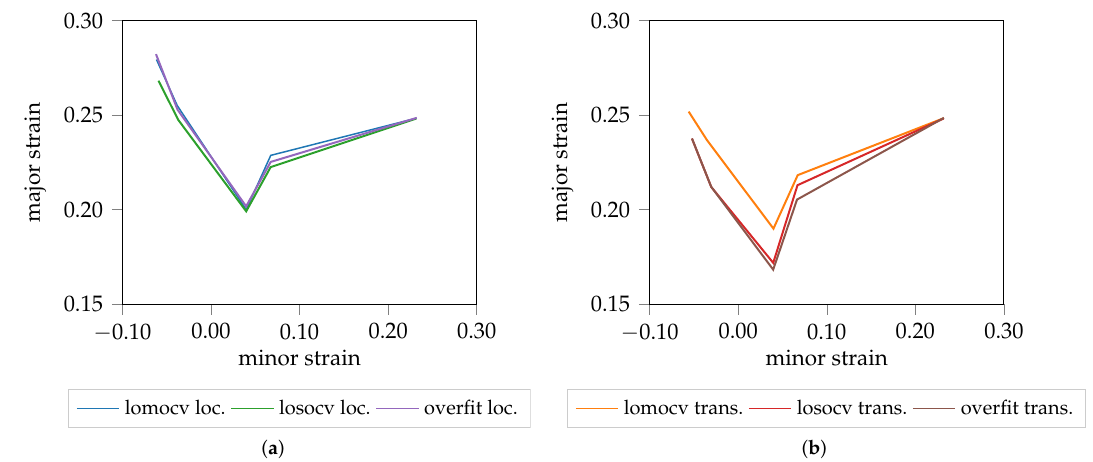
Figure 6. Different FLC candidates of DP800 (1.00 mm). ( a ) localization. ( b ) transition.